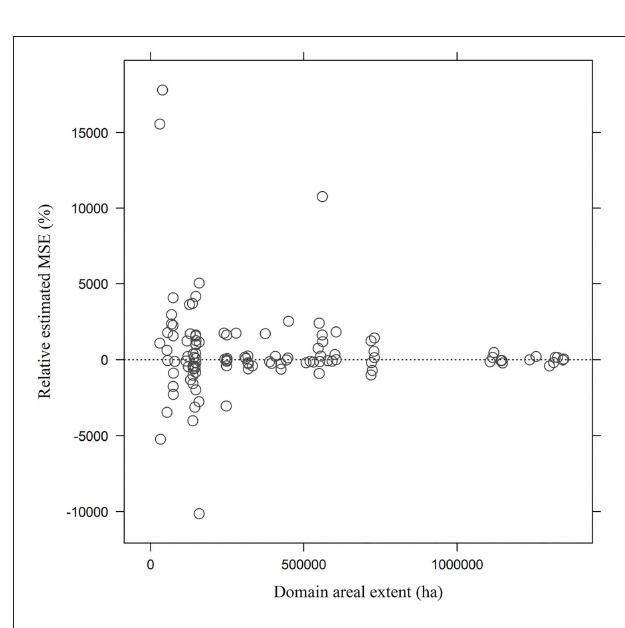
FIGURE 8 | Estimated relative MSE (%) for the indirect domain estimator with δ 2 plotted against domain area (ha), computed individually for each 10 year = domain lag combination using Equation ×